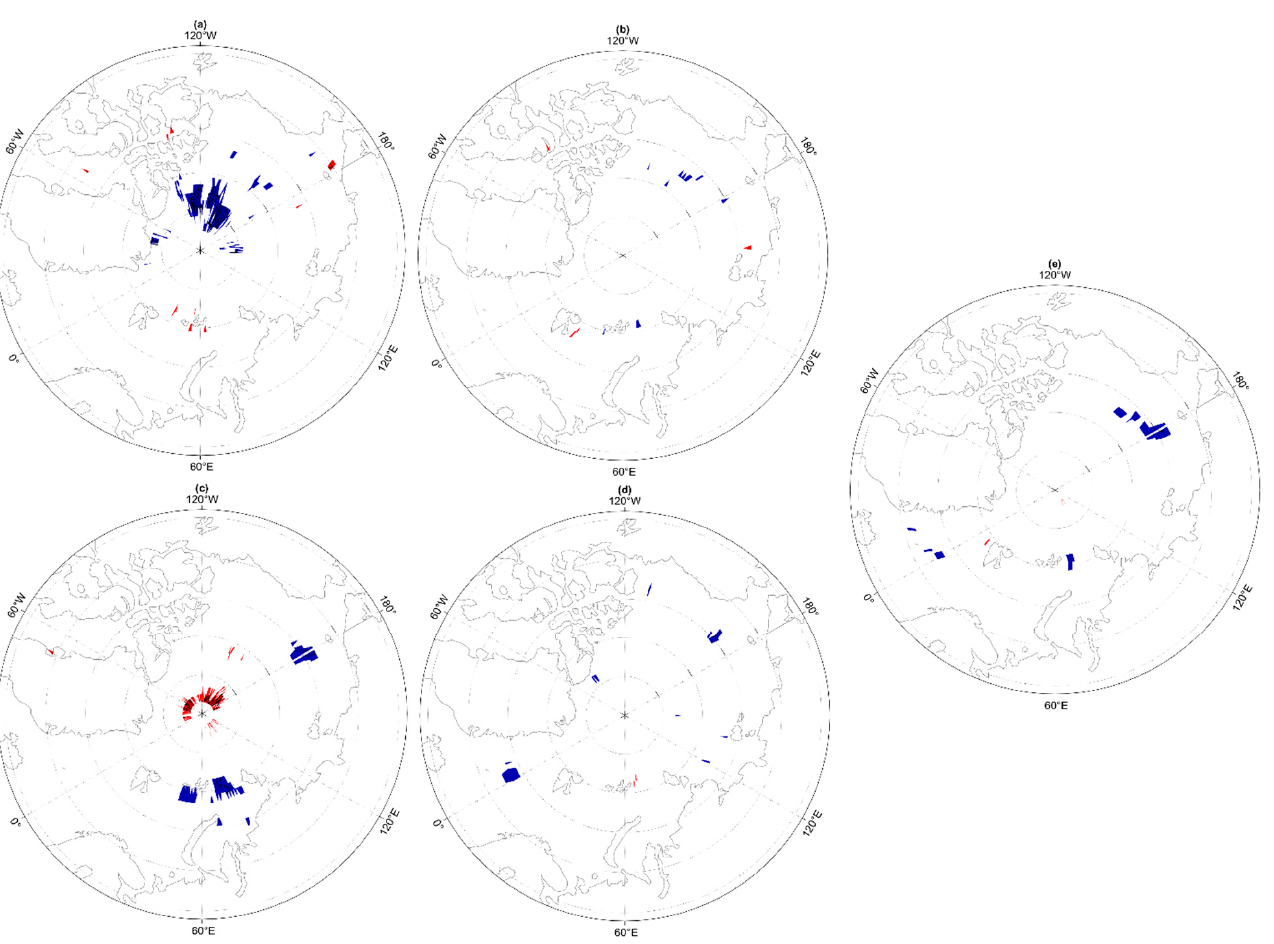
Figure 9. The correlation coefficient between the UBHI in extended winter and SI throughout the four seasons mean (( a ): spring; ( b ): summer; ( c ): autumn; ( d ): winter) and annual mean ( e ) (red shaded area means positive correlation coefficient, blue shaded area means negative correlation coefficient, the absolute value of the correlation coefficient of shaded area is greater than 0.3 and through the test of significance of